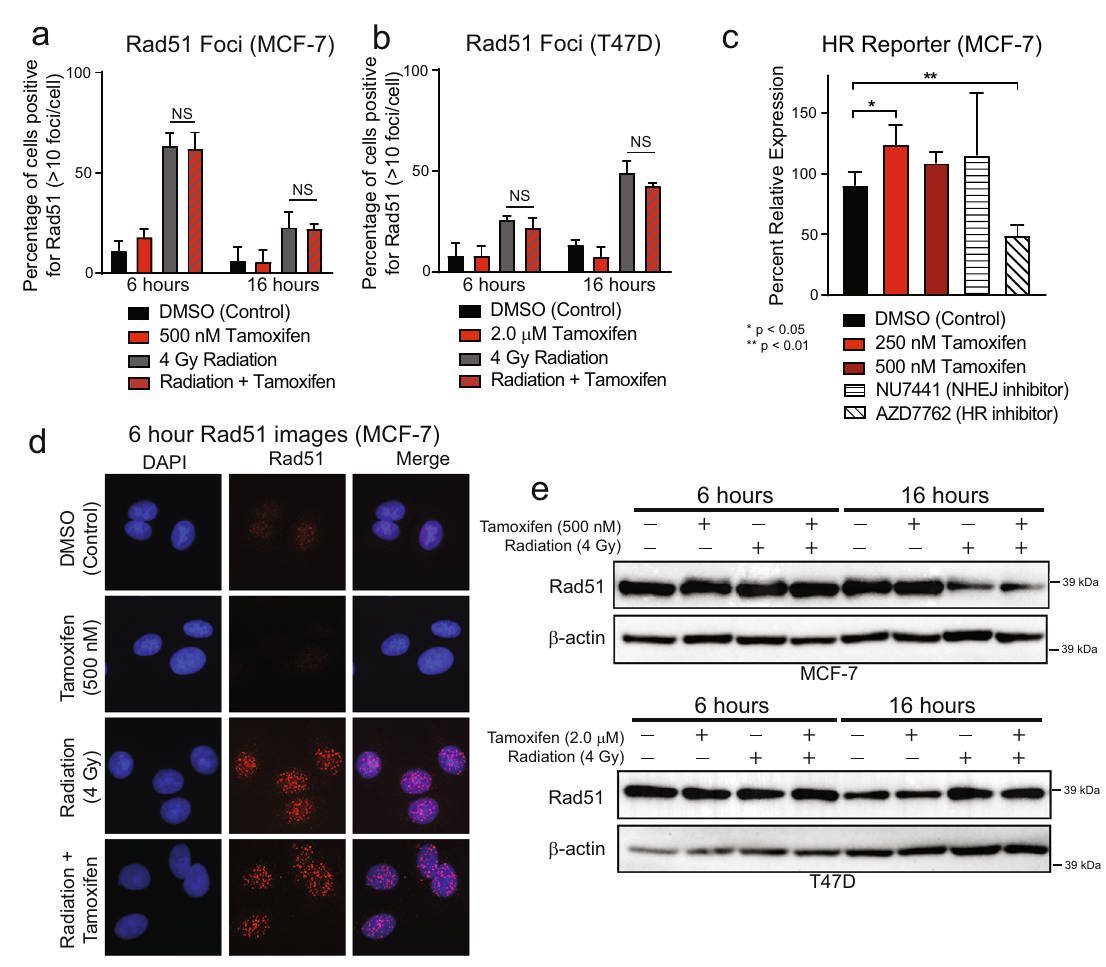
Fig. 3 Tamoxifen does not inhibit homologous recombination ef fi ciency. Immuno fl uorescence was used to stain Rad51 foci in MCF-7 cells treated with ±500 nM tamoxifen ± 4 Gy RT ( a ) and in T47D cells treated ± 2.0 μ M tamoxifen ± 4 Gy RT ( b ). A stable homologous recombination reporter construct was used to assess HR ef fi ciency in MCF-7 cells treated with tamoxifen ( c ). AZD7762, a Chk1/2 inhibitor, was used as a positive control; NU7441, a DNAPK inhibitor, was used as a negative control. Representative images of MCF-7 Rad51 foci at the 6 h timepoint are shown ( d ). Total Rad51 protein levels were assessed by western blot in MCF-7 and T47D cells treated ± tamoxifen ± RT at 6- and 16-h post- RT ( e ). Data from three or four replicate experiments are graphed as mean ± SD. (* P < 0.05; ** P < 0.01; NS = not signi fi